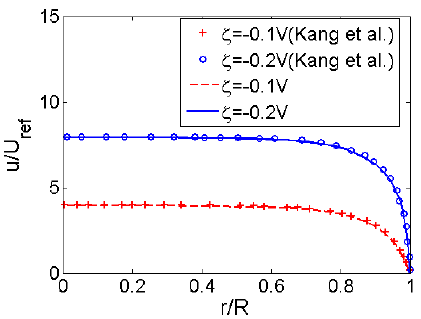
Figure 2. Comparison of the velocity profiles of EOF in the cross section of a single pore from the present model and the existing model of [30] at high zeta potentials where n = 1, K = 10 and the reference velocity U ref = ( ε r ε 0 / m ) ⋅ Ε ⋅ ( k b T / e ). In Figure 3, the velocity profiles of shear thinning fluid, Newtonian fluid and shear thickening fluid are compared in the case of K = 10 and ζ = − 0.1 V. To evidently exhibits the in fl uence of fl ow